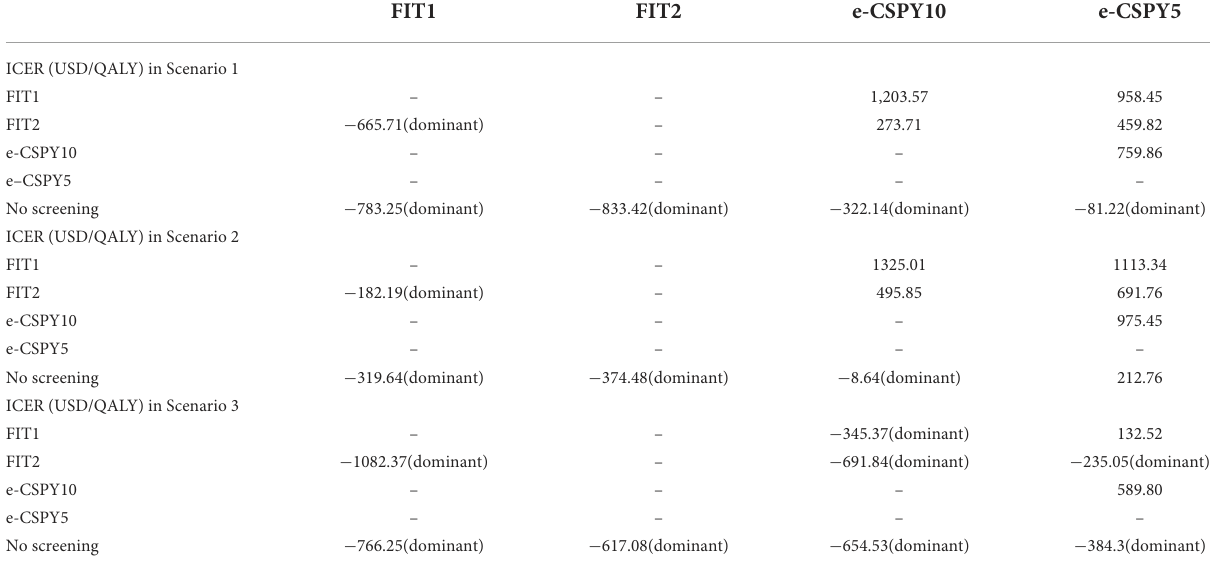
TABLE 6 Number of colorectal cancer patients and deaths in all